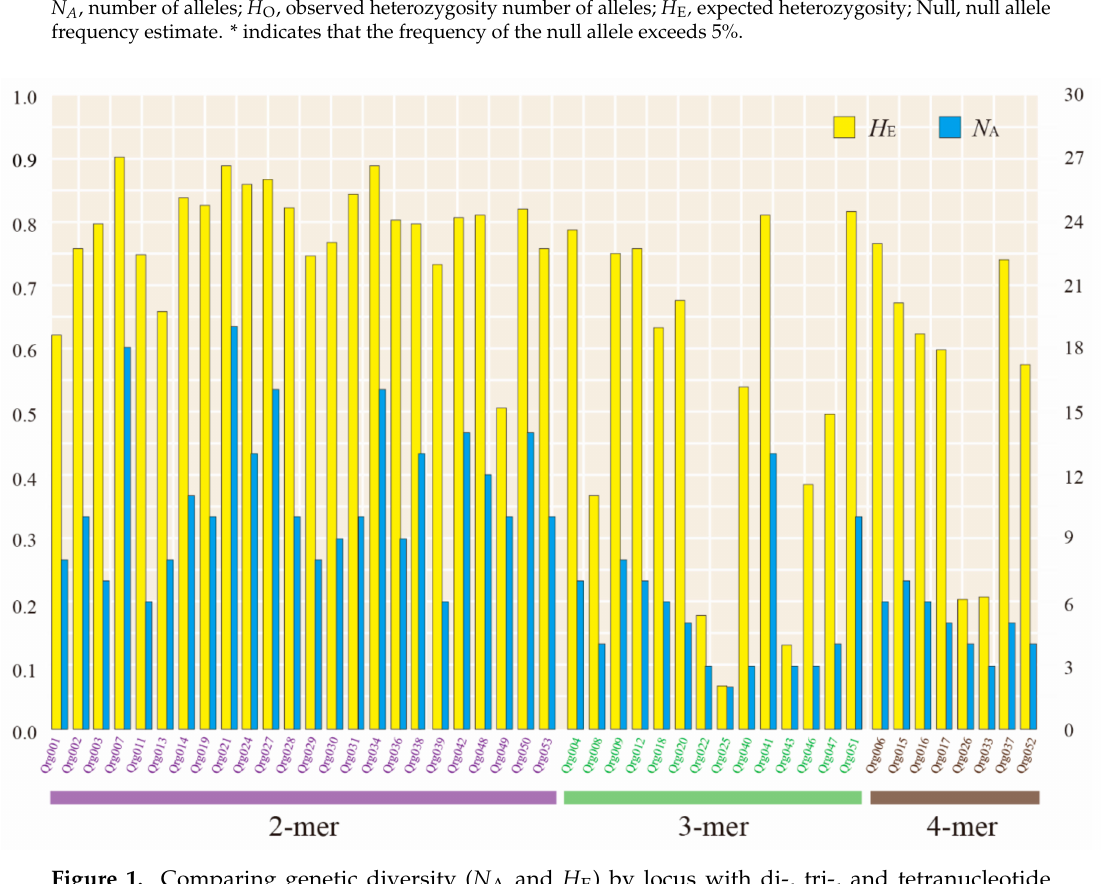
Figure 1. Comparing genetic diversity ( N A and H E ) by locus with di-, tri-, and tetranucleotide motifs. Genetic diversity is based on the allele frequency of six populations of Quercus gilva using 46 microsatellite